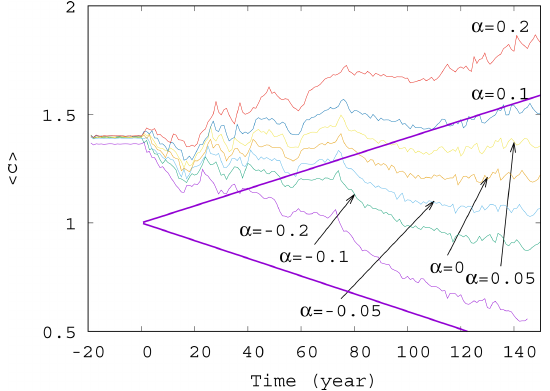
Figure 4. Ensemble-averaged phytoplankton concentration < c > as a function of time for α = 0 . 05 for various values of γ ( γ = 0, 0.001, 0.002, 0.003, 0.004, and 0.005). The thick red line shows the expected phytoplankton concentration in lack of mixing ( γ = 0) as predicted by Eq. (11).